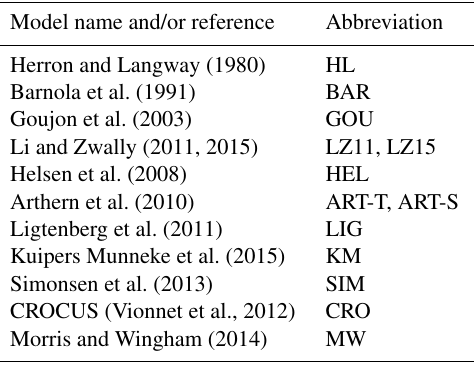
Table 1. List of firn densification models and their abbreviations coded in the CFM and included in the study detailed in Sect. 3. Arthern et al. (2010) describe two different models; see Sect. 2.2.6 for